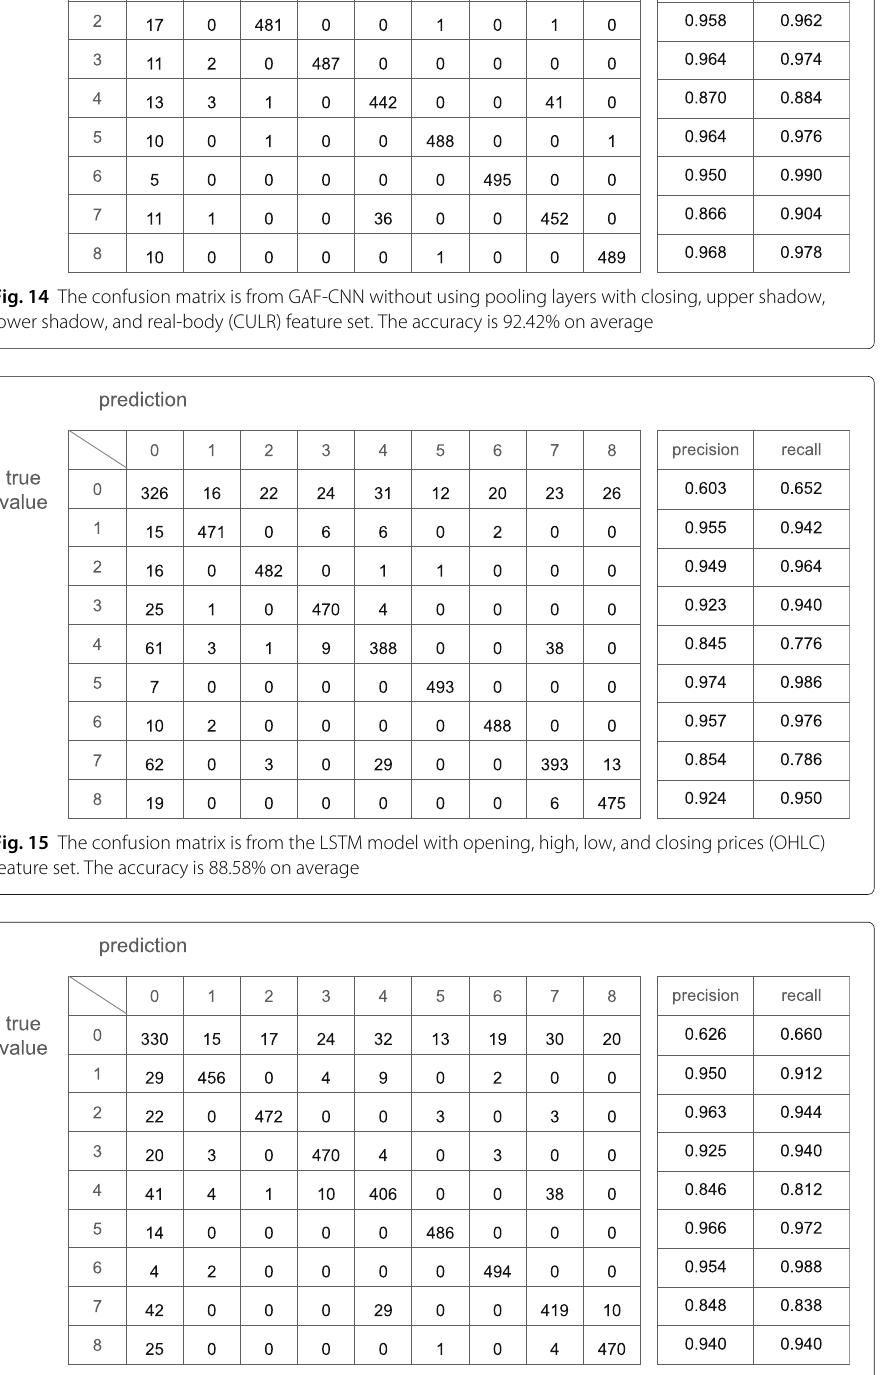
Fig. 16 The confusion matrix is from the LSTM model with closing, upper shadow, lower shadow, and real-body (CULR) feature set. The accuracy is 88.96% on